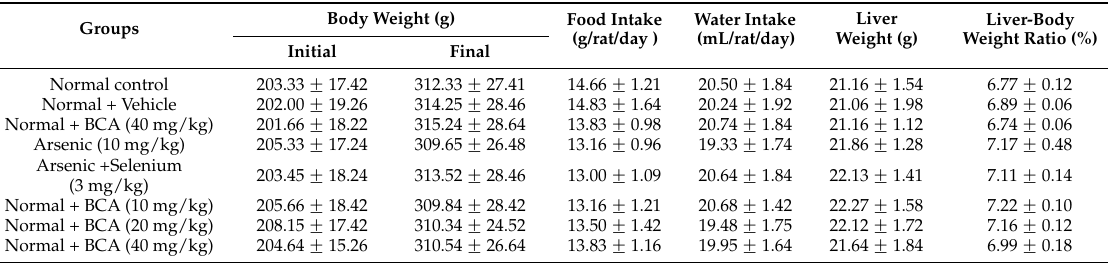
Table 1. General characteristics of normal control and experimental